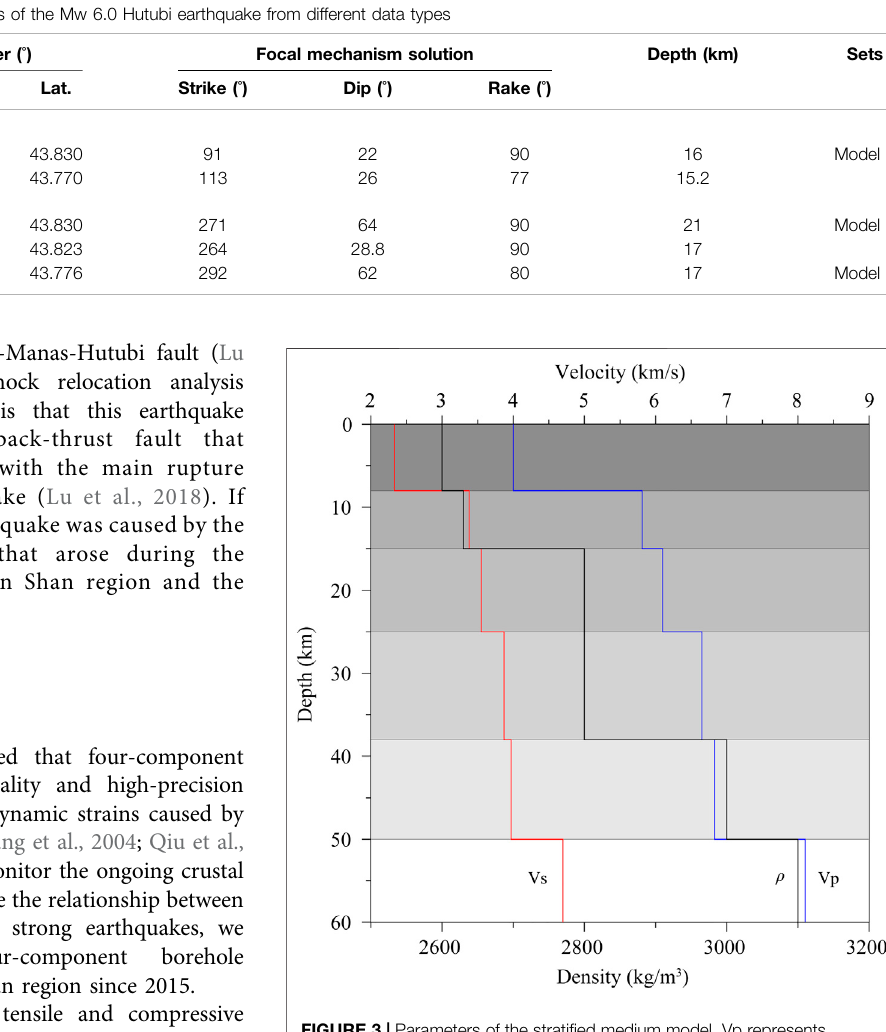
Inthetable,theazimuthofcomponentisde fi nedaszerointhenorthdirection,andtheclockwiserotationispositive;1to4representthefourcomponents; ‘ + ’ and ‘–’ representtensileand compressive strain, respectively, and tensile strain is considered as positive.